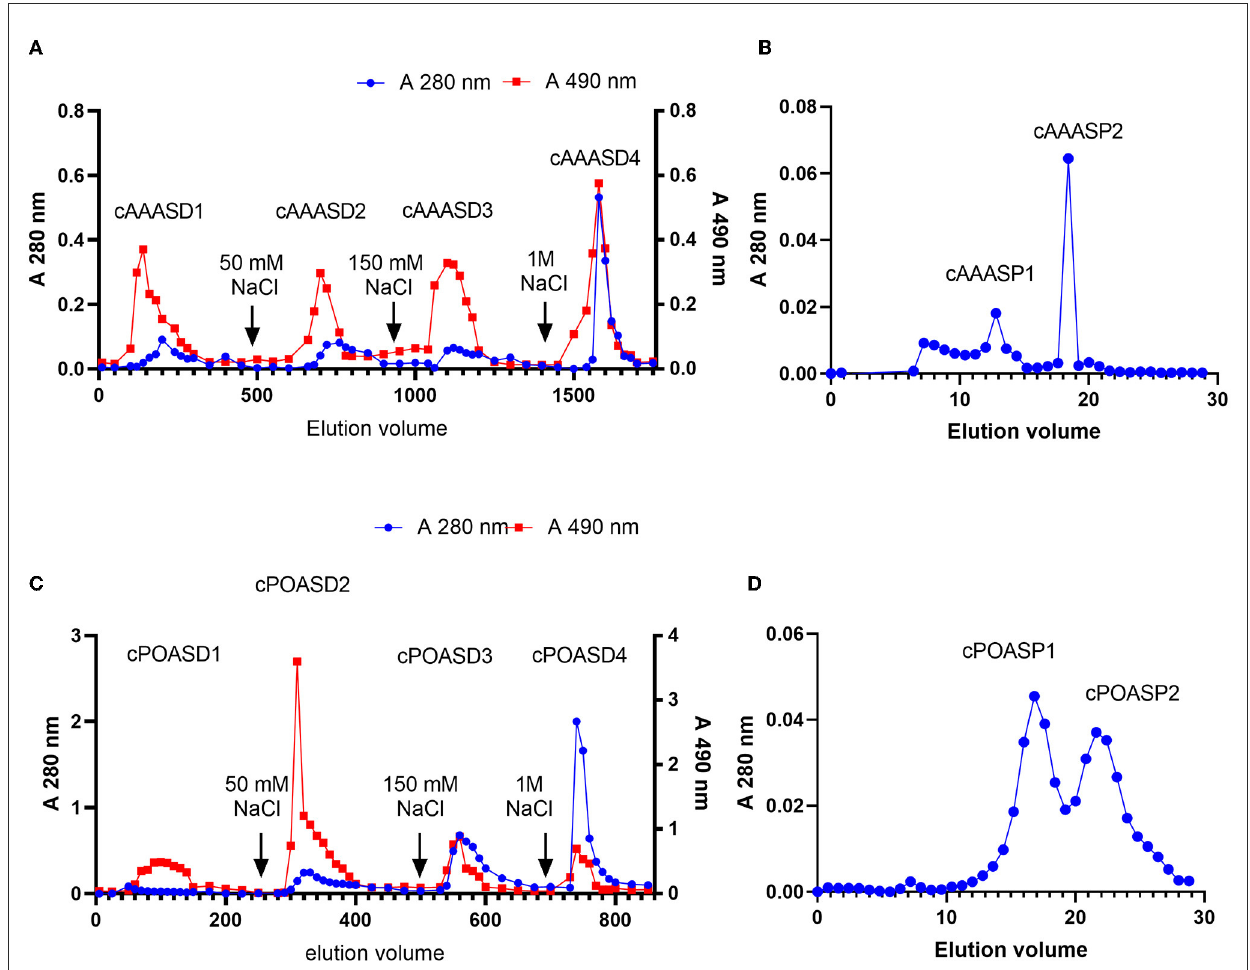
FIGURE2 Elution curves of AAAS and POAS. (A) cAAAS on DEAE-Sepharose column (40 × 400mm). (B) cAAASU2 on Superdex peptide 10/300 GL. (C) cPOAS on DEAE-Sepharose column (40 × 400mm). (D) cPOASU2 on Superdex 75 10/300